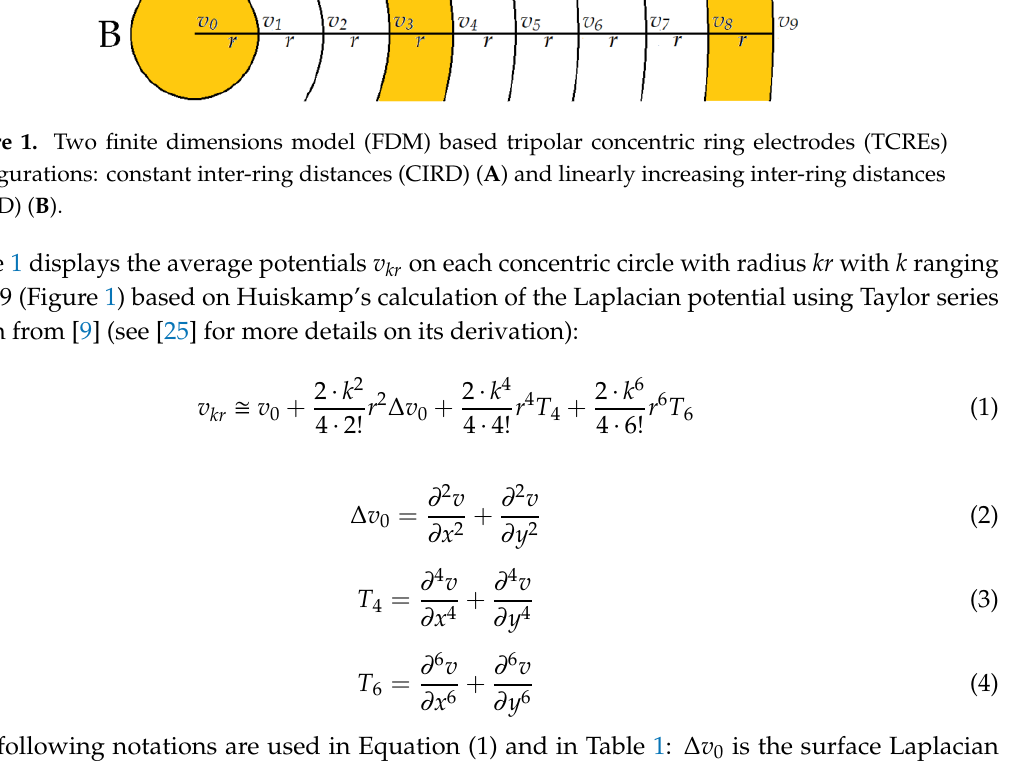
Table 1. Taylor series for concentric circles.